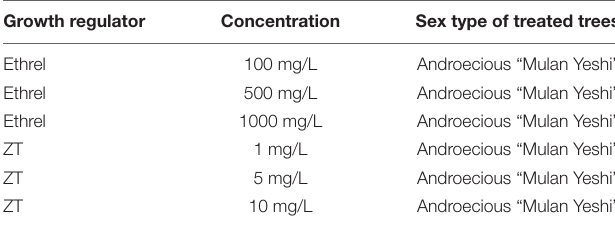
TABLE 1 | Treatments and types of treated